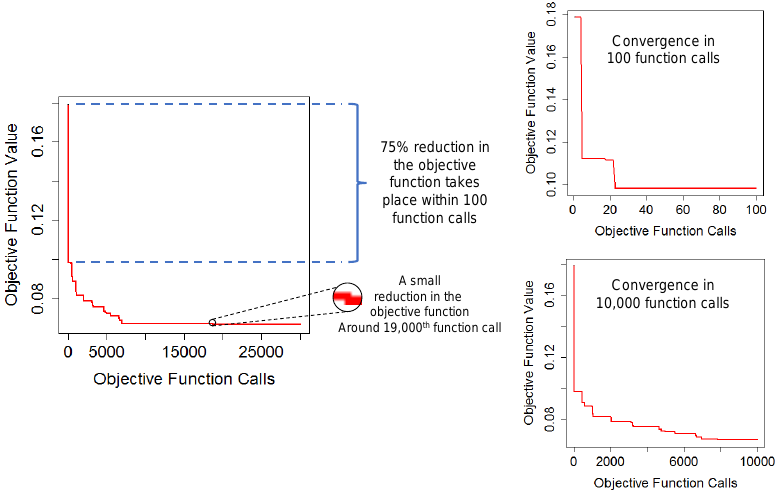
Figure 9. Convergence graphs obtained by running 30,000 function